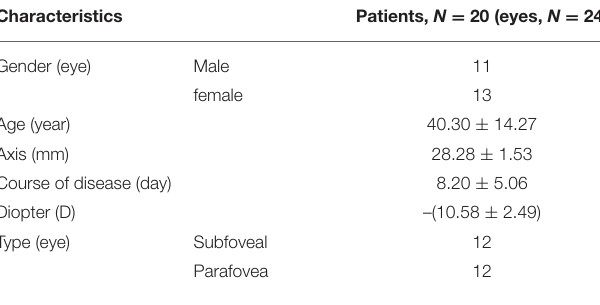
TABLE 1 | Patients bisic characteristics ( x ± s n =